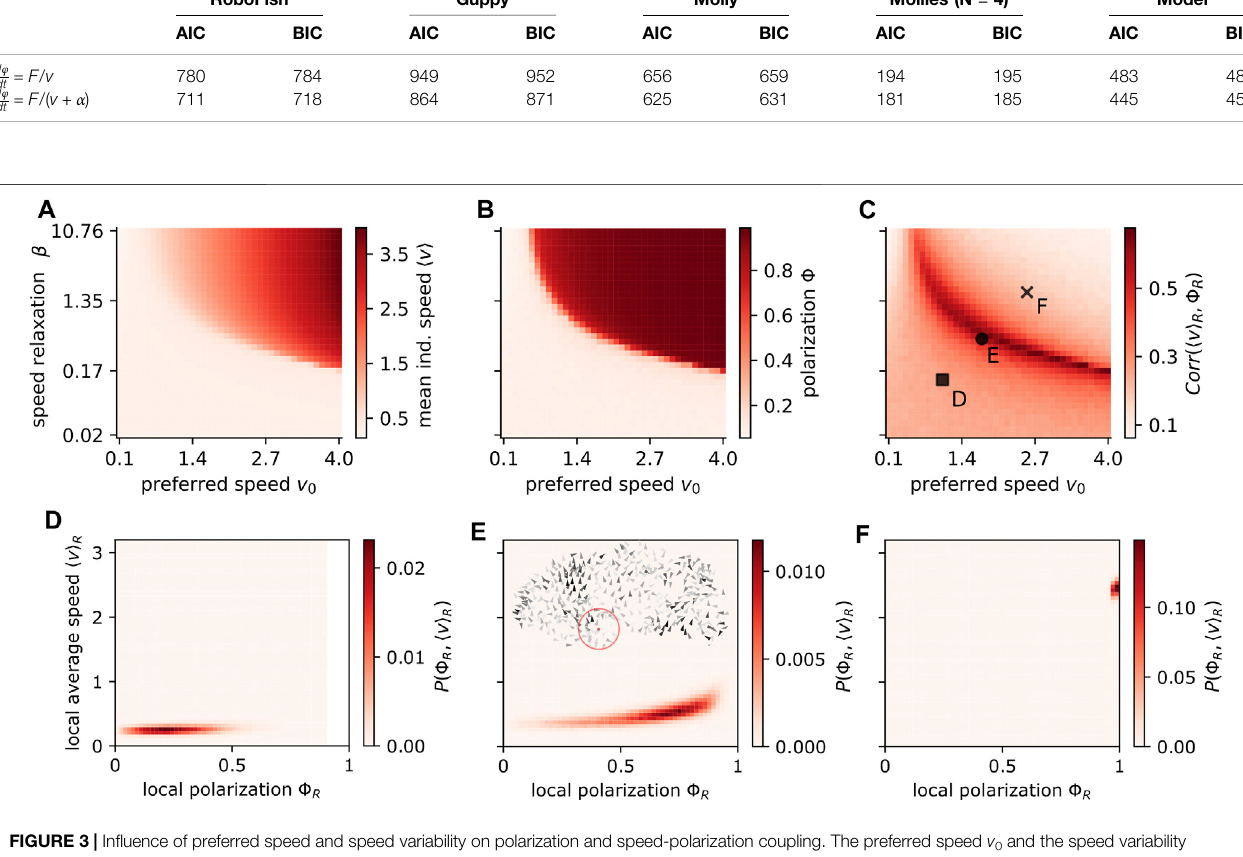
fi c dependence